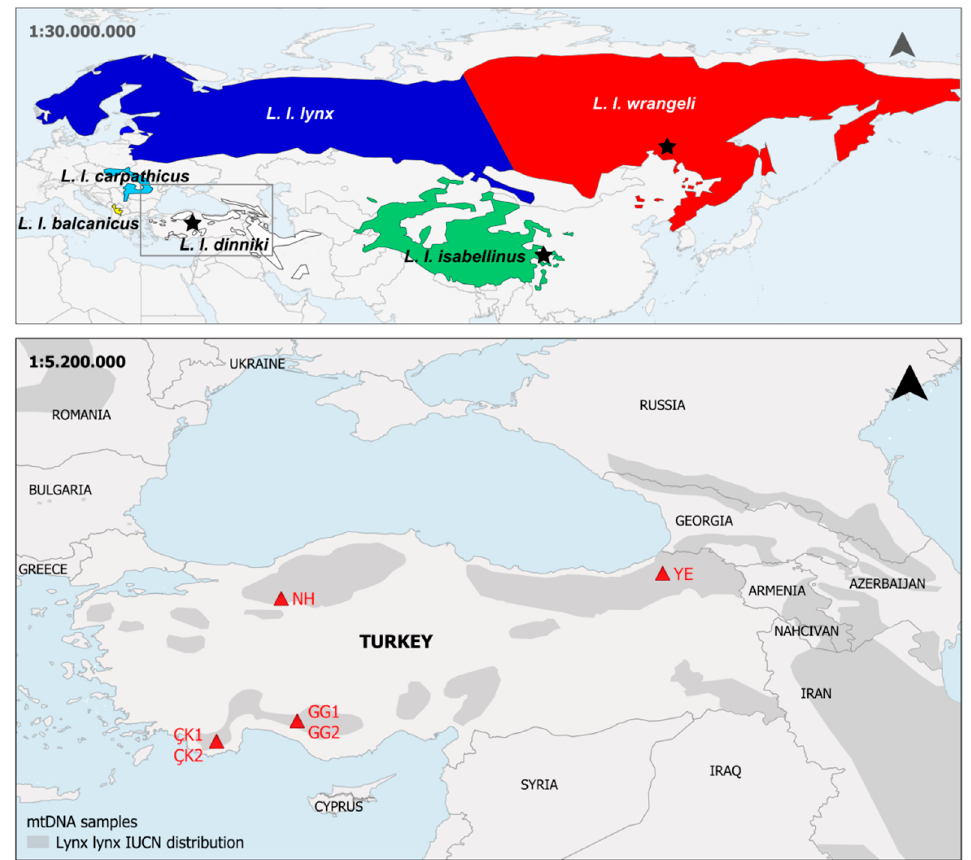
Figure 1. Top: Map of Eurasian lynx subspecies distribution. Stars indicate source area of mitogenomes added to the dataset in [18] (this study; [38,47]). Bottom: Map of Turkey depicting the locations of the four sampling sites for L. l. dinniki in Turkey. These sites are the Çı˘glıkara Forest Reserve (ÇK) and the Gidengelmez Mountains (GG) in Southwest Anatolia, the Nallıhan Mountains (NH) in Northwest Anatolia, and the Yusufeli-Kaçkar Mountains (YE) in the Lesser Caucasus. Shaded areas indicate the distribution of Lynx lynx [5].